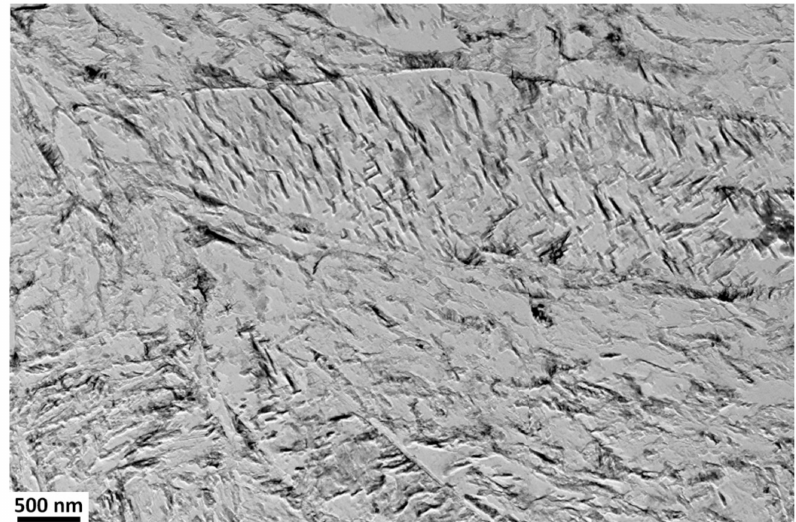
Figure 9. SAT 250–350, TEM carbon replica with extracted carbides. Elongated lamellar-like carbides of Fe 2 C can be found in all samples where the carbon replica analysis was performed. Two variants—Fe 2 C- ε and Fe 2 C- η carbides—were found in QT250. In other samples, only one type—Fe 2 C- ε was found. Furthermore, many smaller, almost equiaxial particles were observed in all the samples. These particles were identified as Fe 5 C 2 (Hägg carbide) or transition Fe 4 C (Figure 10).